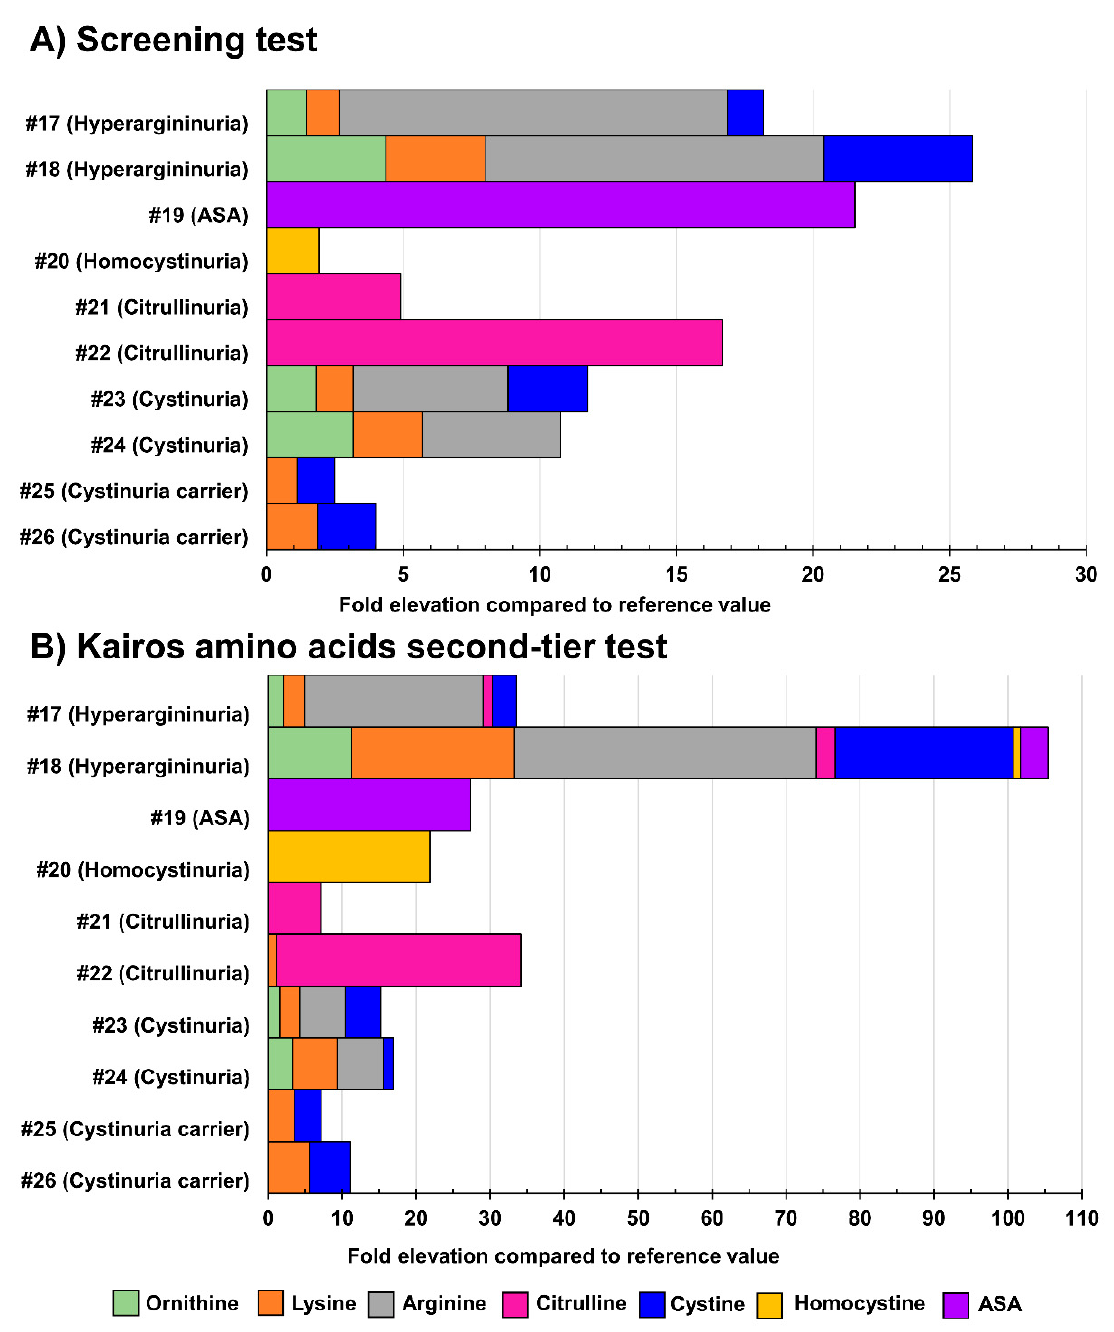
Figure 7. Fold-elevation compared to reference values in urine samples from patients with confirmed aminoacidurias (relevant biomarkers targeted by the Kairos amino acid second-tier test). Results obtained as part of the screening test are shown in ( A ), while ( B ) displays results obtained as part of the Kairos amino acid second-tier test. The fold-elevation compared to reference values corresponds to the width of the bar for each molecule. ASA: argininosuccinic aciduria.